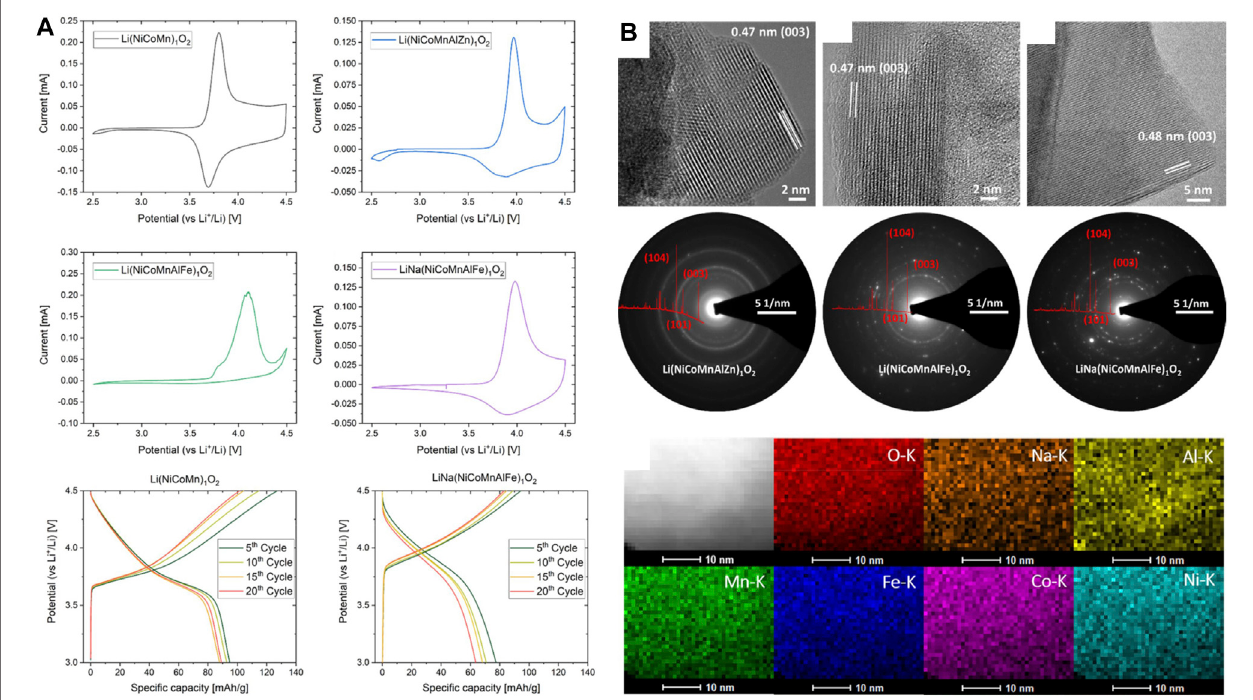
FIGURE3 |(A) CV and voltage pro fi les and (B) HR-TEM, SAED, and EDX mapping characterizationoflayered HEO cathode (J. Wang, et al., 2020b).Reproduced under the terms of the CC BY